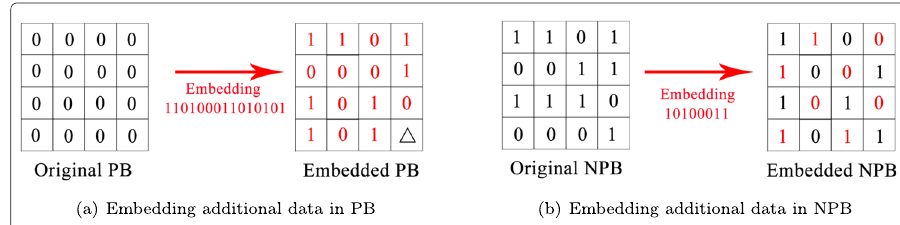
Fig. 5 Embedding additional data in 4 × 4 PB block and NPB block. The symbol (cid:8) indicates the recovery pixel, which is not used to embed